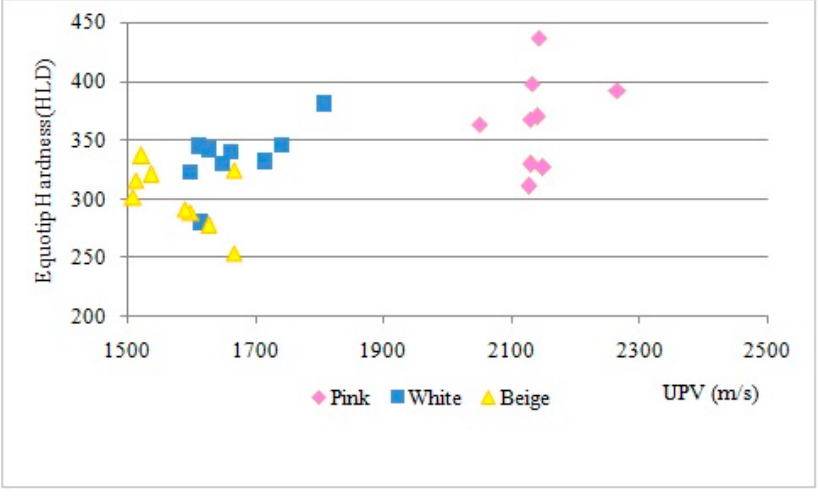
Table 4. Results of color measurement.